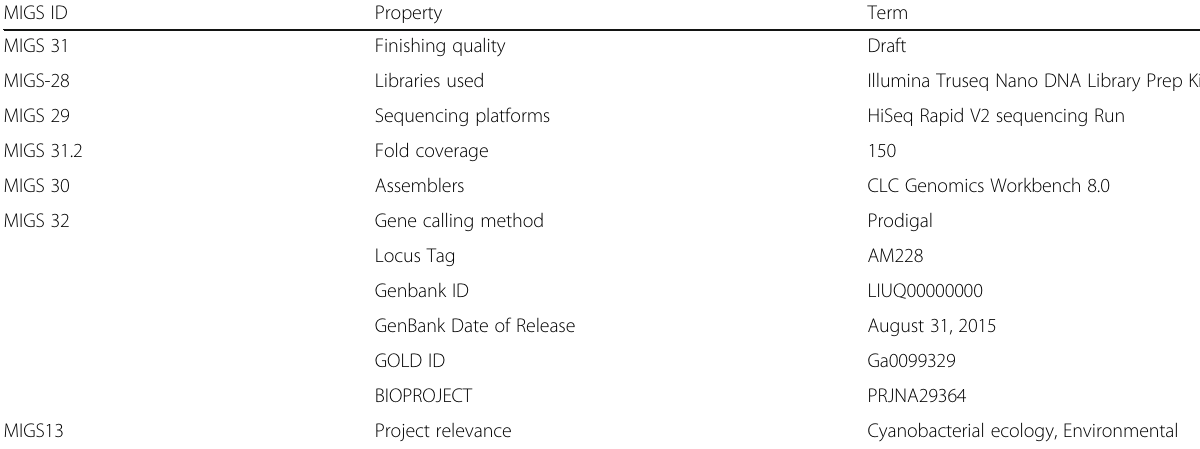
Table 2 Project